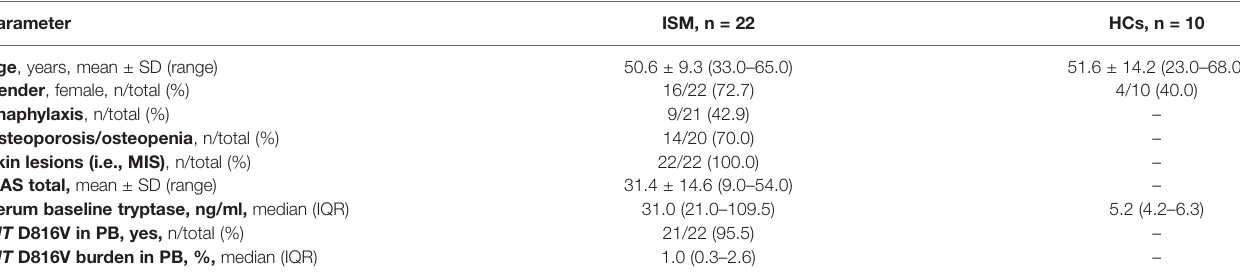
TABLE 1 | Demographic, clinical, and laboratory characteristics of ISM patients and healthy